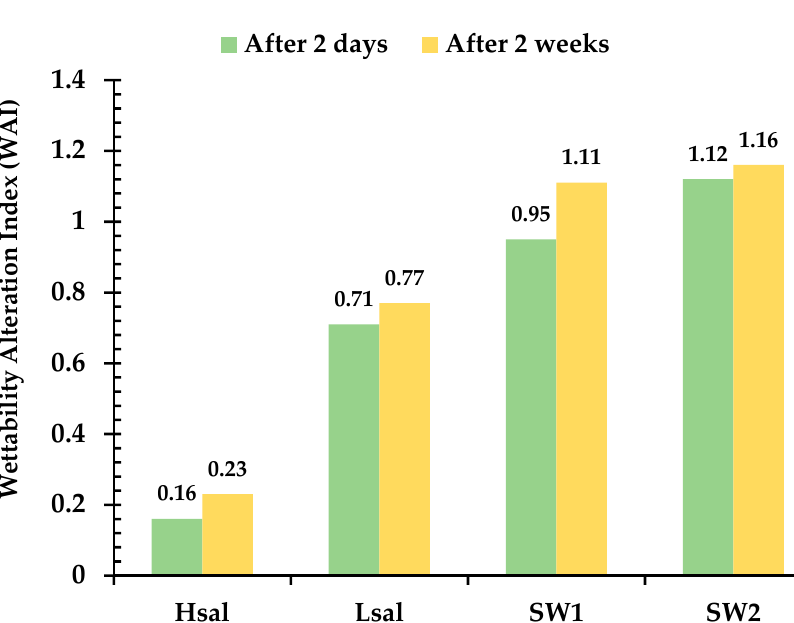
Figure 13. WAI for Case 5 (strongly oil wet) calcite surface aged using different brines.